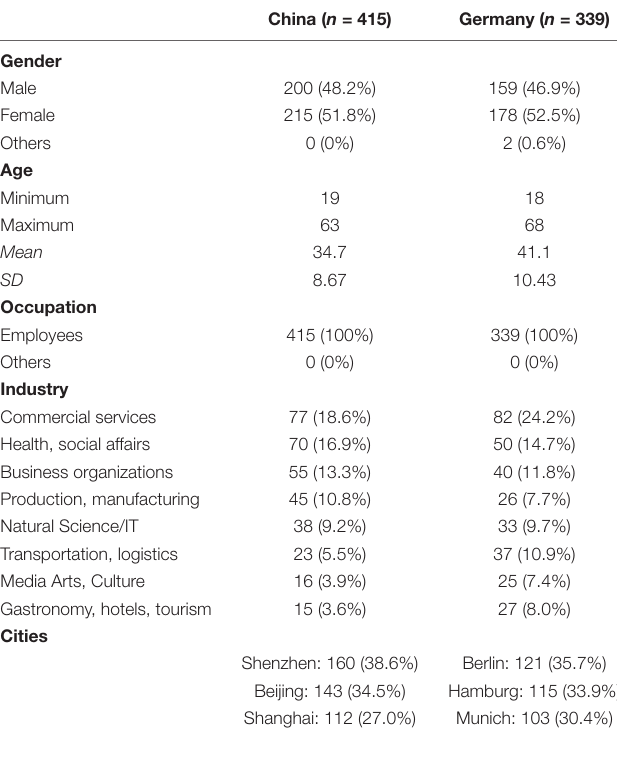
TABLE 1 | Sample demographic